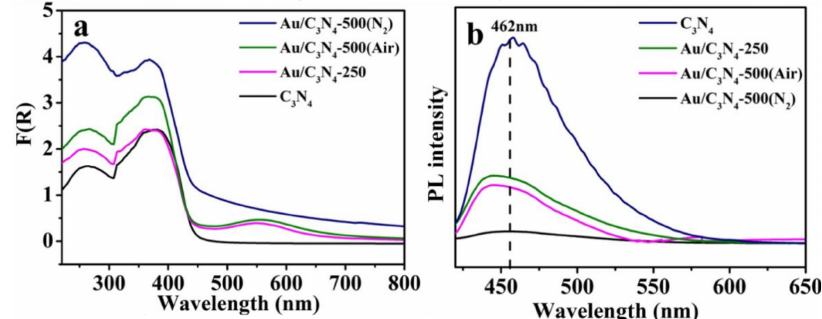
Figure 4. ( a ) Ultraviolet (UV)/Visible diffuse reflectance spectra; ( b ) fluorescence emission spectra of C 3 N 4 , Au/C 3 N 4 -250, Au/C 3 N 4 -500(Air), and Au/C 3 N 4 -500(N 2 ); across an excitation wavelength of 400